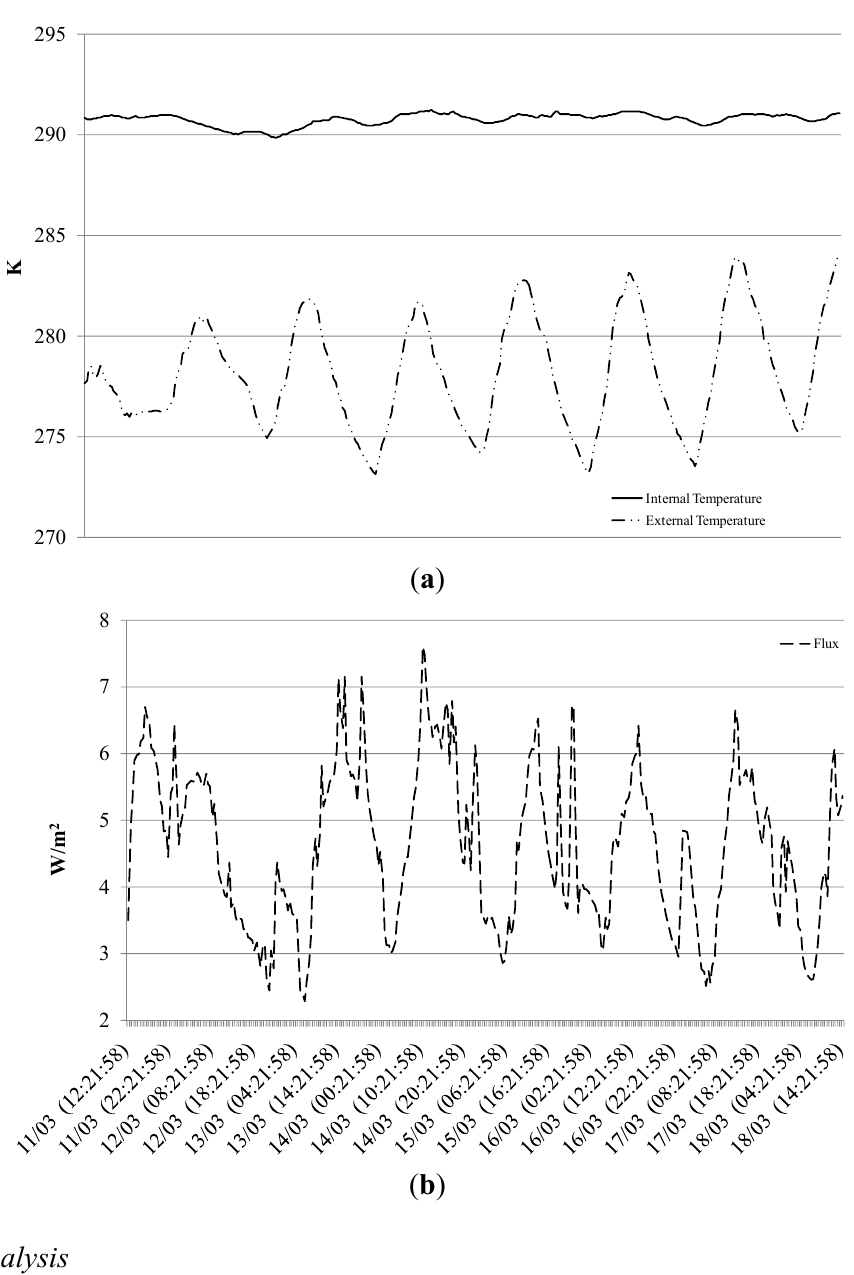
Figure 7. Trends of internal and external temperature ( a ) and heat flux during ( b ) the in-situ thermal transmittance